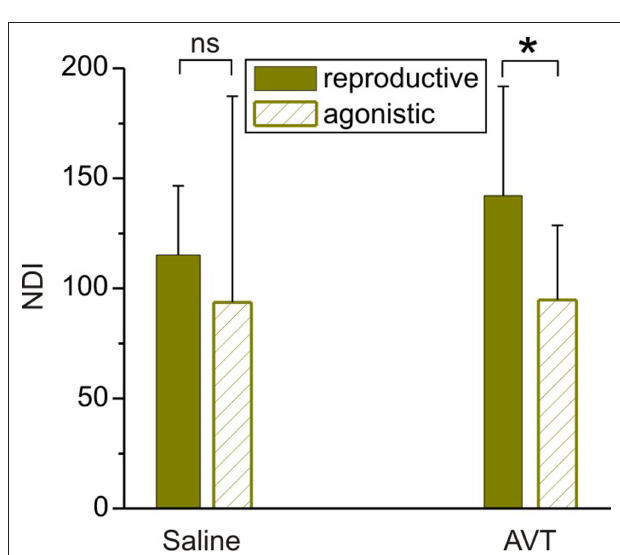
FIguRE 4 | Effects of MC upon the nocturnal increase of EOD rate in breeding Brachyhypopomus gauderio. (A,B) EOD rate as function of time (60 min before artificial sunset to 120 min after, lights off at time = 0, vertical line) in one representative male–female dyad following Protocol I. (A) Day 1 corresponded to an intact breeding dyad, that spontaneously exhibited a large nocturnal increase of their EOD rates as described by Silva et al. (2007). (B) In day 2, MC (10 μg/gbw) was administered to the male 15 min before the artificial